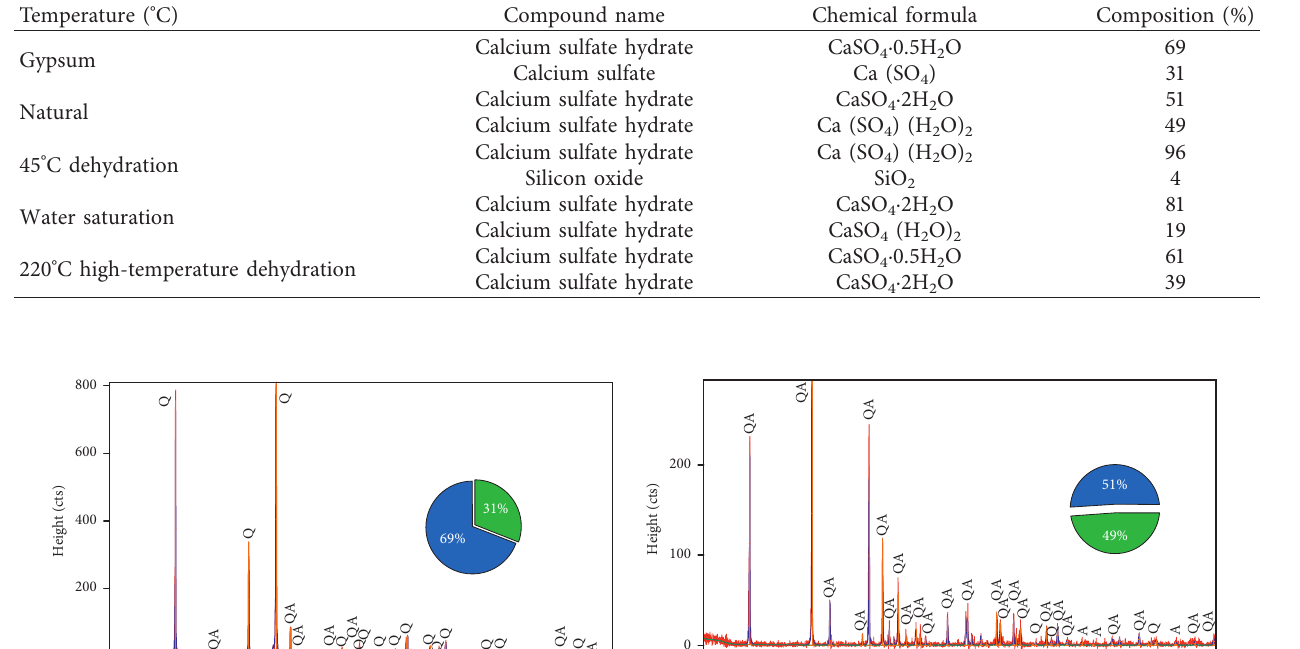
Figure 13: Failure modes of triaxial compression of each group of samples. (a) Natural. (b) Dehydration at 45 ° C. (c) Water saturation. (d) High-temperature dehydration at 220 ° Table 4: The main mineral composition of gypsum powder remolded samples in different states.